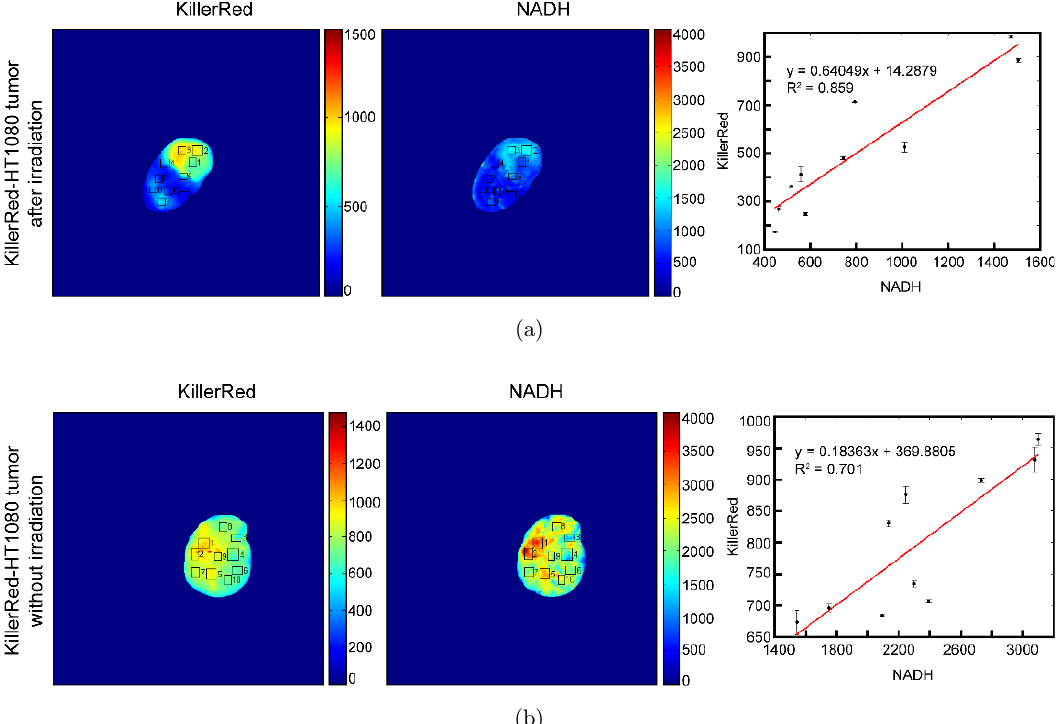
Fig. 5. The correlation between the distribution of KillerRed protein and that of NADH. (a) Tumors after irradiation treatment and (b) Tumors without